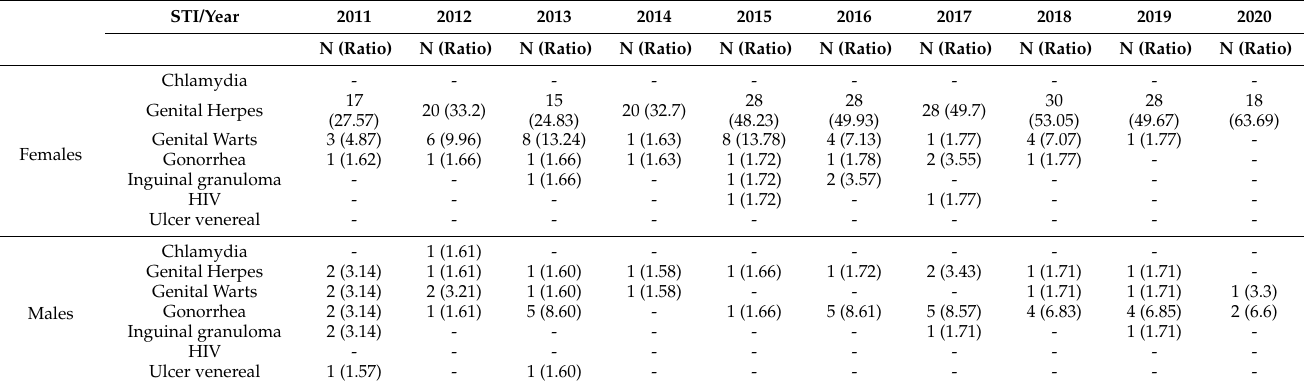
Table 3. Emergency department (ED) visits, absolute frequency and cause specific ratio per 100,000 ED visits, by gender and year of observation. Period 2011–2020, Piedmont region,